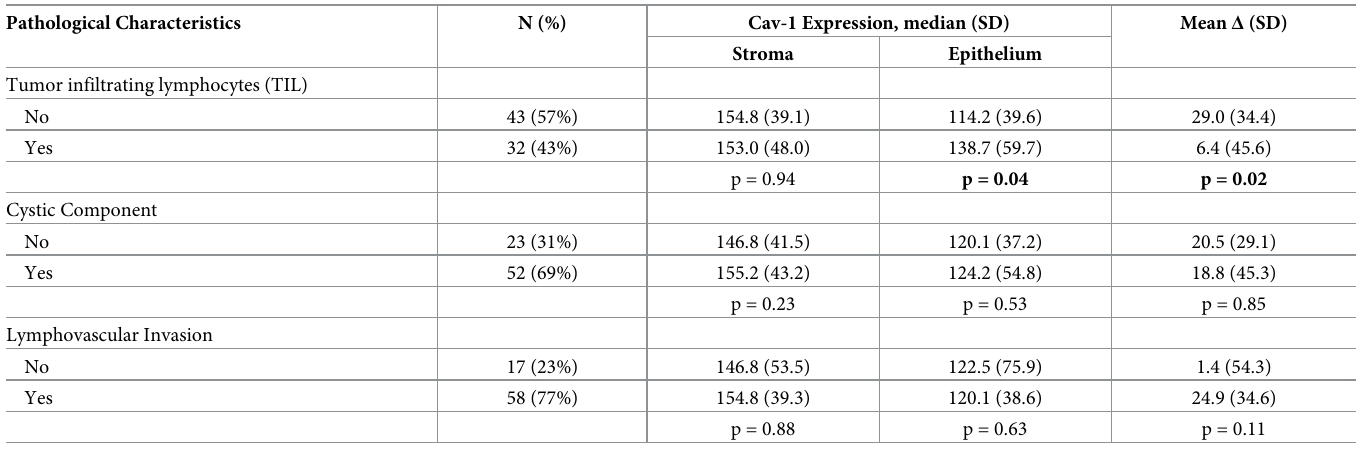
SD, standard deviation. P-values comparing Cav-1 expression by subgroups were calculated using Wilcoxon rank sum test. P-values for comparison of mean difference were calculated using Student’s t-test.